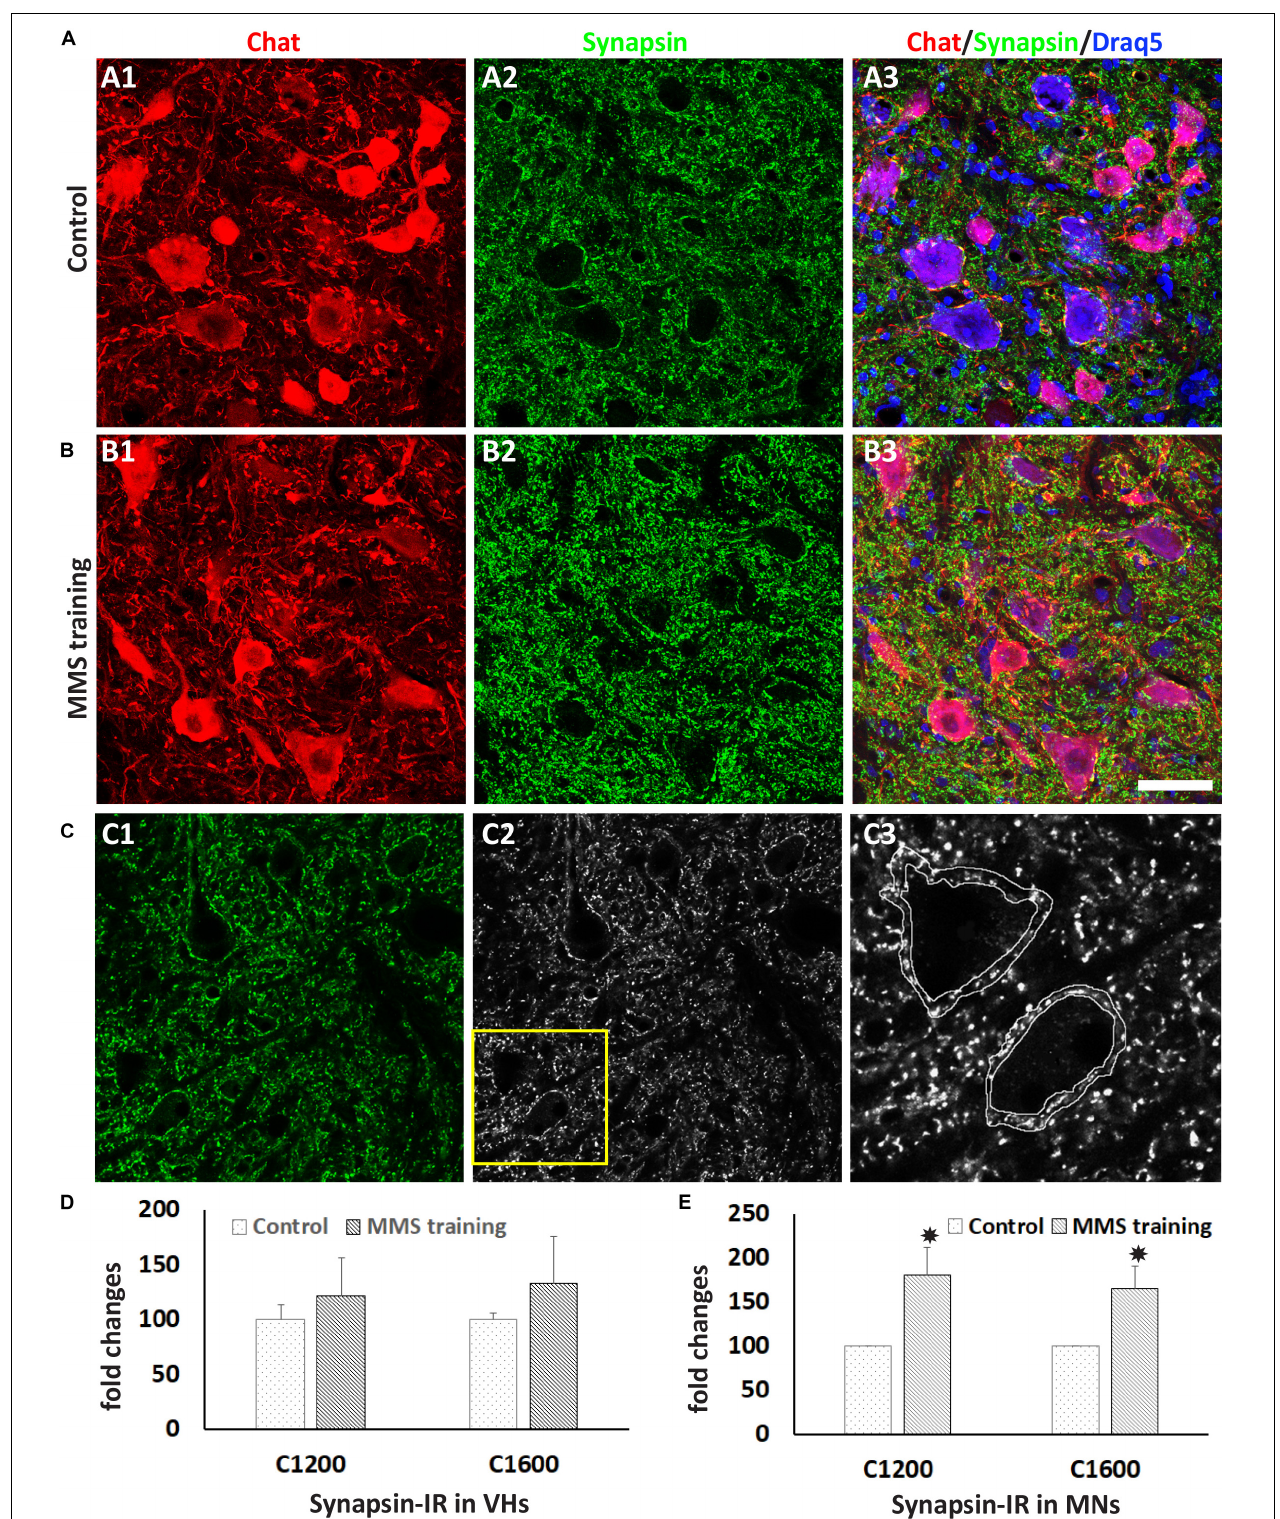
FIGURE 4 | Synaptic plasticity after Modified Montoya Staircase (MMS) rehabilitation. Motor neurons and presynaptic terminals in the ventral horn were labeled immunohistochemically using antibodies against choline acetyltransferase (ChAT) and synapsin, respectively (A,B) . Representative immunolabeling images in (A) and